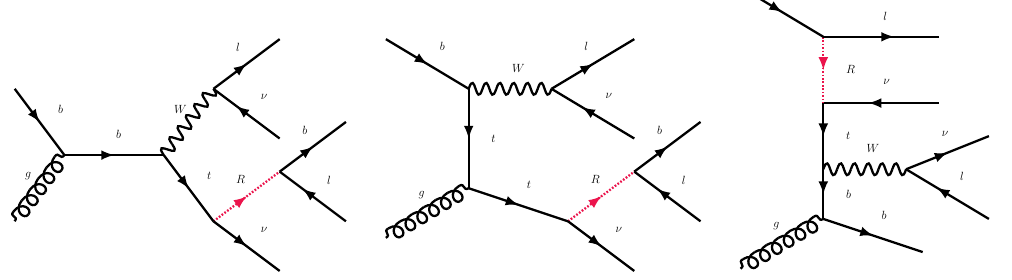
bl + (cid:23)l (cid:0) (cid:22) (cid:23) . The LQ lines are !